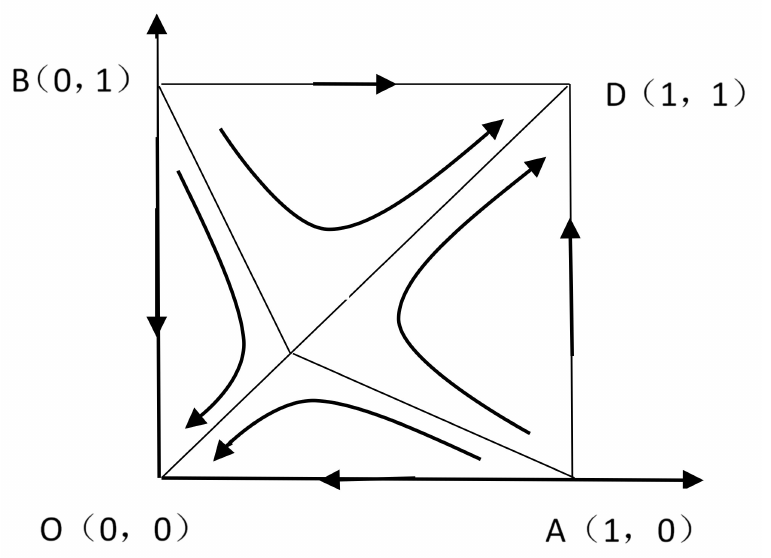
Figure 1. Evolutionary phase diagram of the game between farmers and agricultural enterprises.